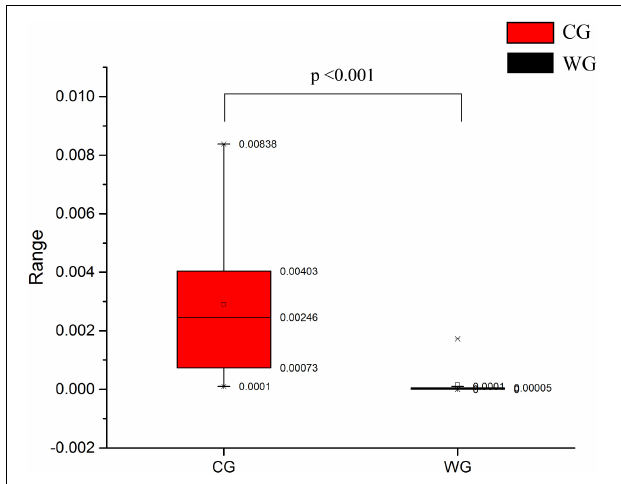
FIGURE 5 | Comparison of methanobacteriaceae relative abundance between CG and WG.